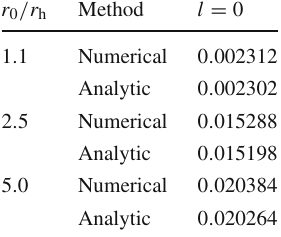
Table 2 Spectra of the energy radiated to infinity in the ZFL for l = 0. The numerical results are compared with the exact values given by Eq. (45) (the results for l > 0 are identically zero), considering the source released from rest at a certain finite position r 0